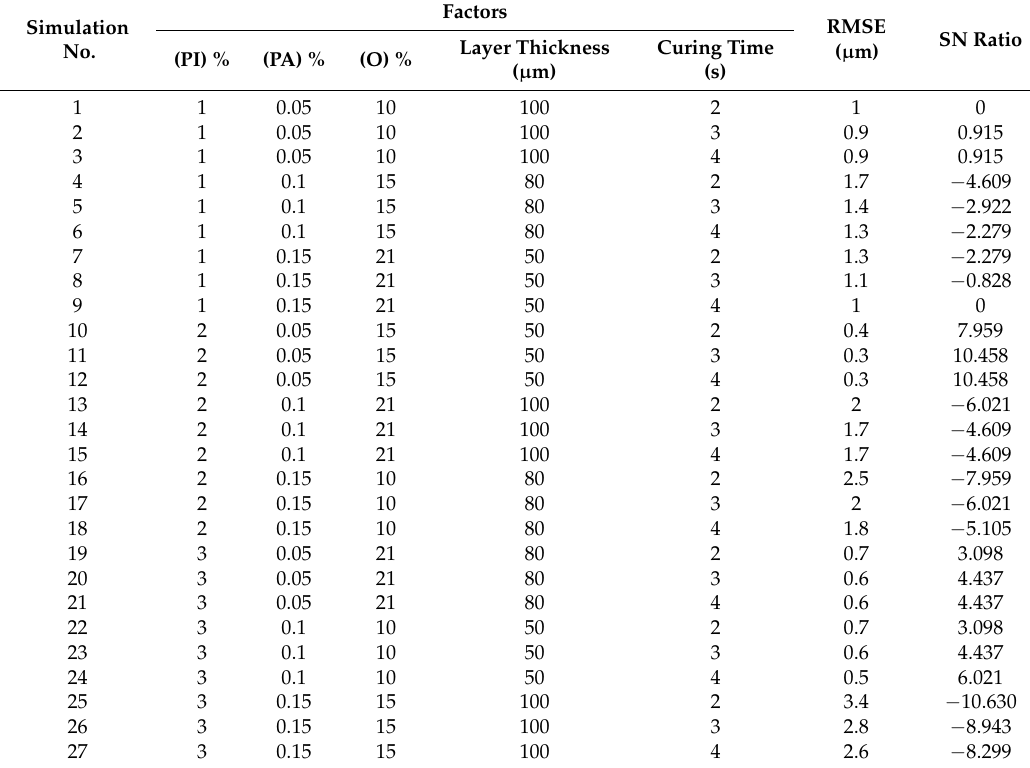
Table 5. Factor and levels for Taguchi